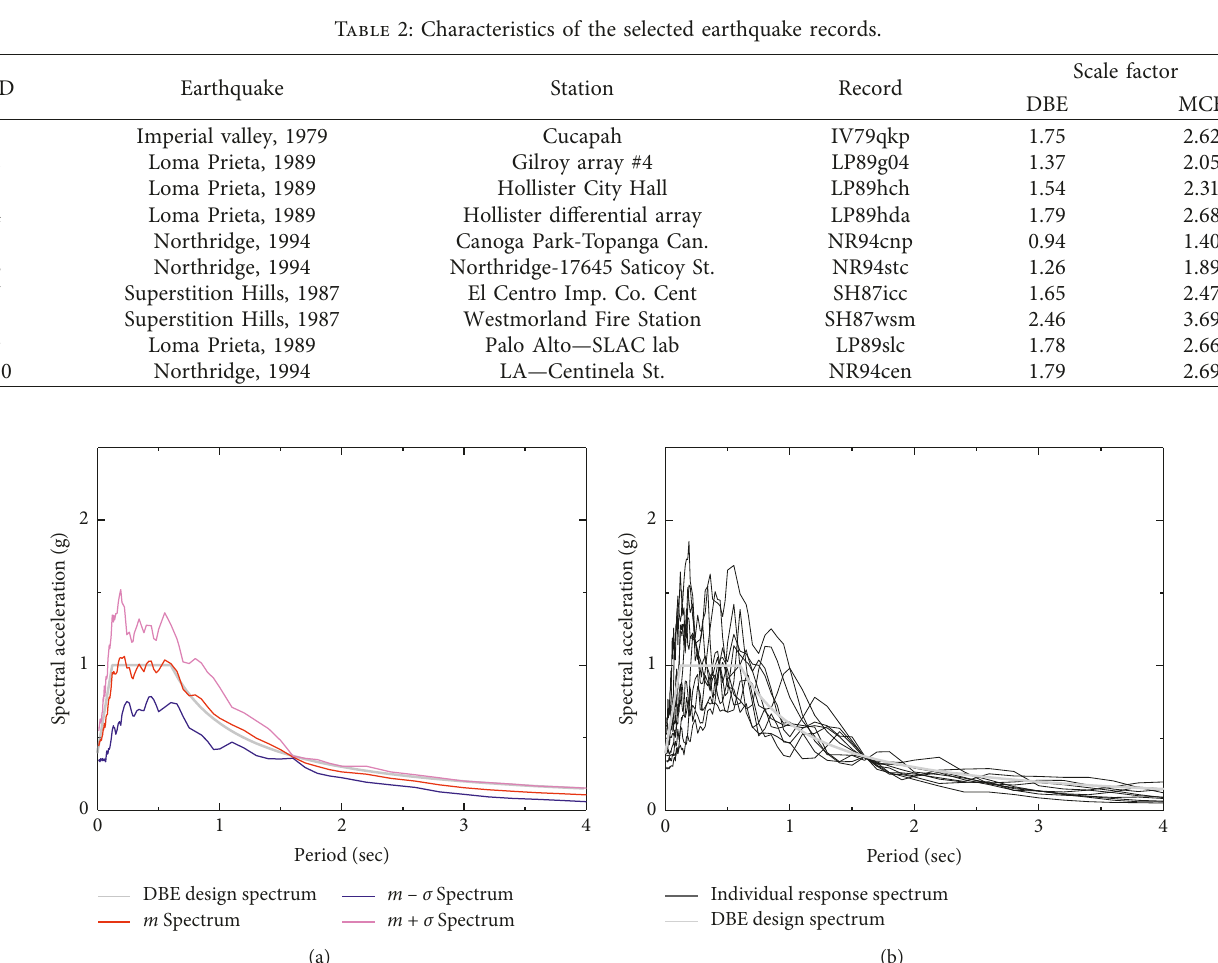
Figure 5: Comparison of the design spectrum with the spectra of the ground motions. (a) Mean and DBE spectra. (b) Individual spectra scaled to DBE.